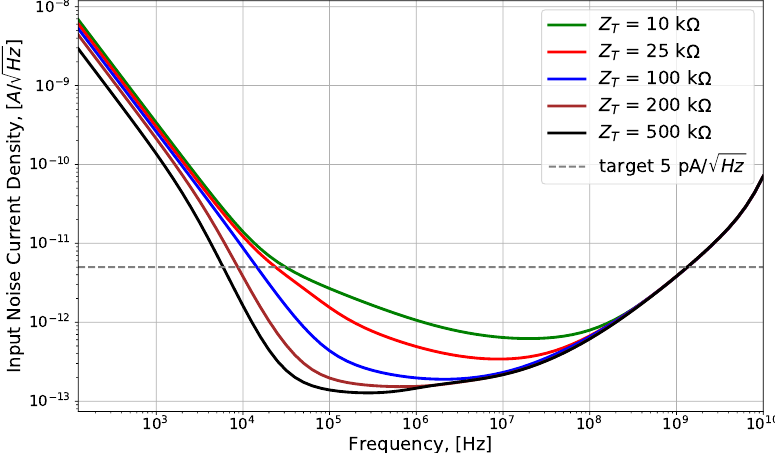
Figure 12. Cadence-simulated noise for programmable-gain TIA configuration with cascode I SS in TSMC 0.18 µ m CMOS. The horizontal gray dashed line indicates the target noise level of 5.0 pA/